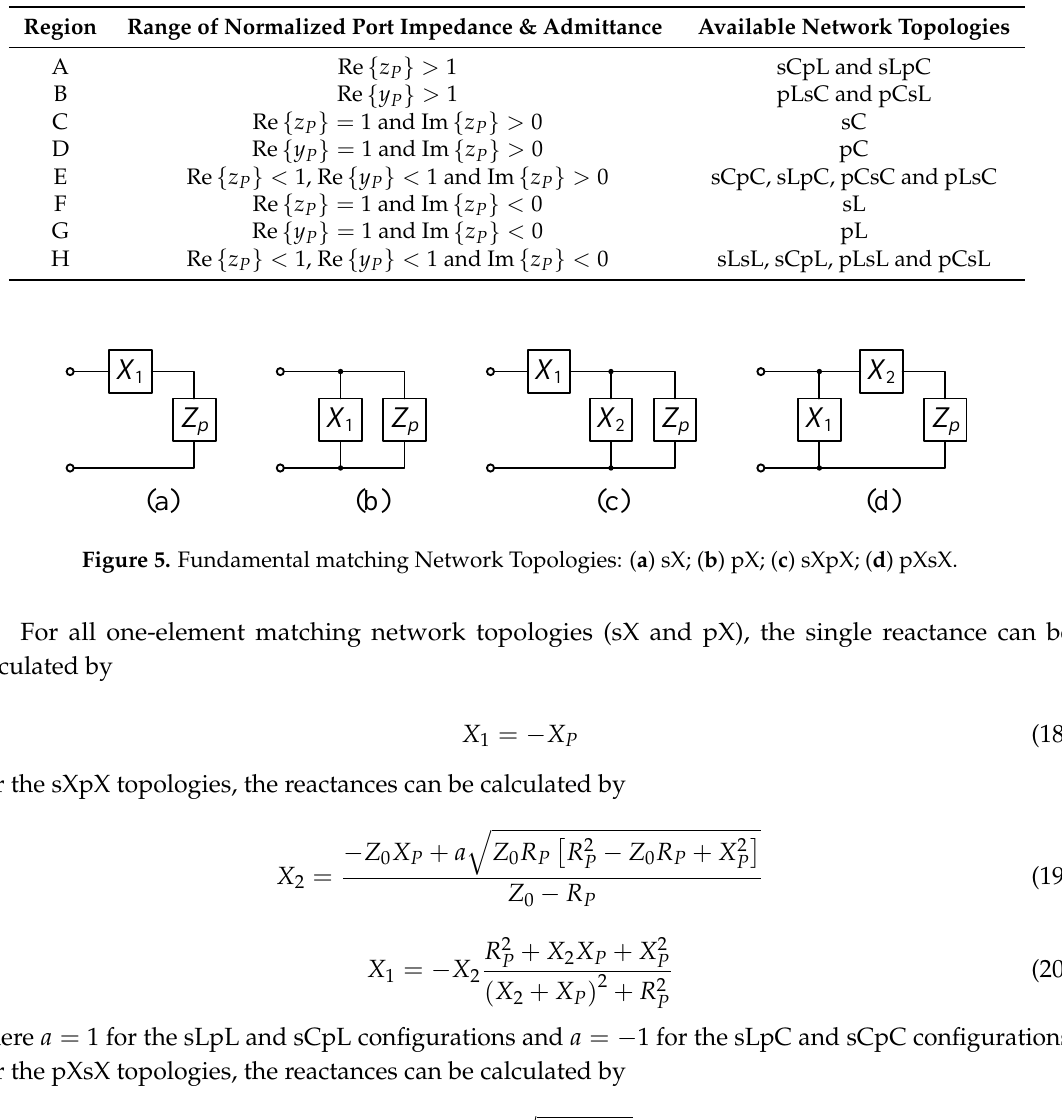
Table 1. Impedance range of and network topologies available for each region on Smith chart.